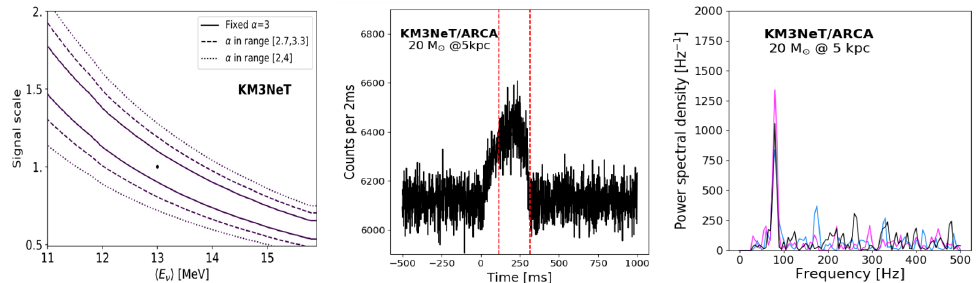
Figure 2. Left: 90% confidence level contours in the signal scale and neutrino energy parameter space. Middle: the neutrino rates in the full ARCA detector for of a 20 M red lines correspond to the interval where SASI is searched for [3]. Right: Power spectral densities for ARCA observations. 80 Hz corresponds to the SASI frequency for the 20 M Figure 1. Left: Number of events per building block as a function of the multiplicity for ORCA (light blue) and ARCA (dark blue) for progenitor masses of 11 M (light orange), 27 M (orange) and 40 M ⊙ ⊙ ⊙ (dark orange). Right: KM3NeT detection sensitivity to CCSN neutrinos as a function of the distance to the star for 11 M (green), 27 M (gray) and 40 M progenitors (violet) [3]. ⊙ ⊙ ⊙